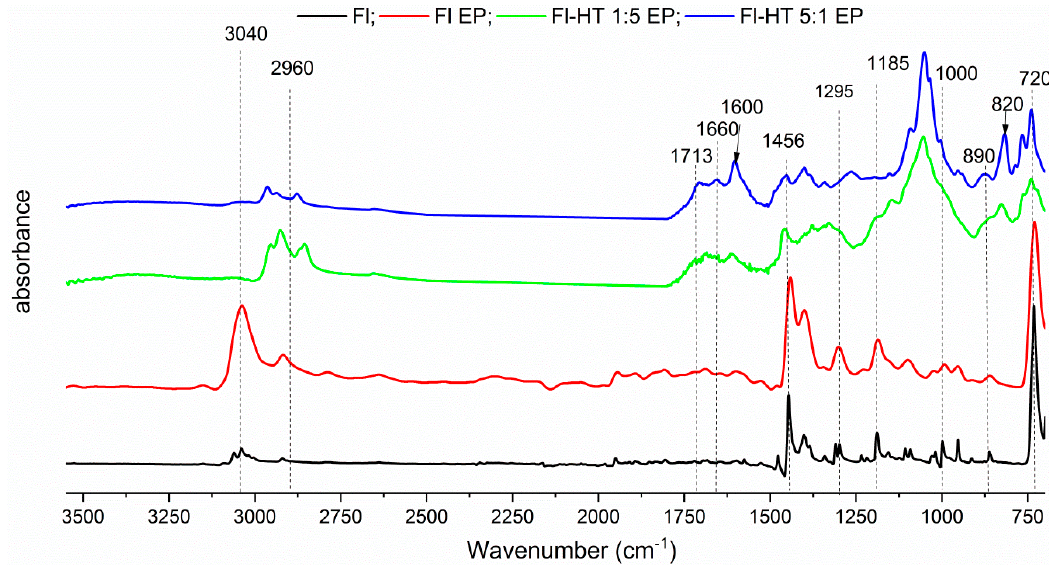
Figure 9. ATR-IR spectra of the fluorene, its homopolymer (Fl EP) layer and Fl-HT EP layers.